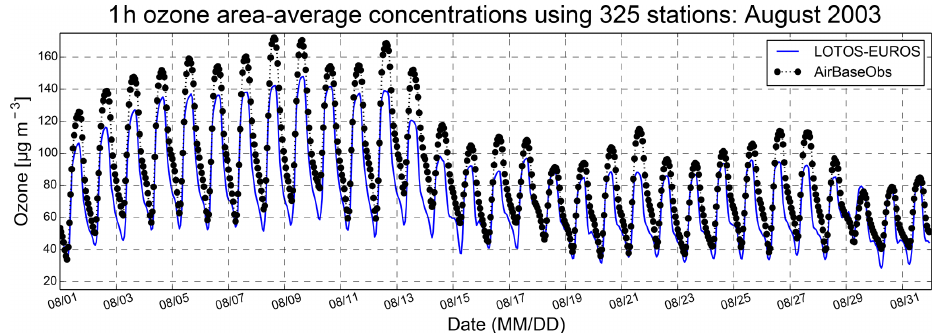
Figure 2. Surface ozone data (µgm − 3 ) averaged over 325 stations during August 2003 as described by the LOTOS-EUROS model (blue line) and compared to AirBase database ground-based stations measurements (black dotted line and circles).